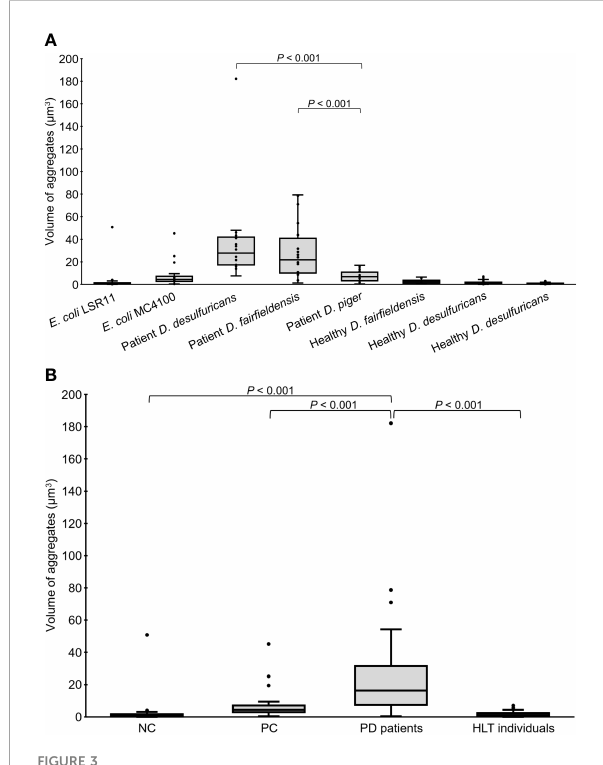
FIGURE 3 Volume of alpha-syn aggregates in the head region of C. elegans at day 4 adult stage fed with different bacteria, demonstrated individually (A) or as groups (B) . NC: E. coli LSR11 (negative control), PC: E. coli MC4100 (positive control), PD patients: DSV strains from patients with PD, HLT individuals: DSV strains from healthy individuals. Twenty worms per bacterial diet were analyzed. The dots represent the worms that were analyzed (A) or outliers (B) . The boxes represent the fi rst and third quartile (lower and upper edges, respectively) and the medians (horizontal line within the